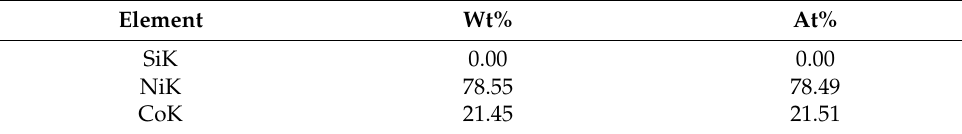
Figure 1. EDX result for the 0.5% SiO 2 /Co 2.4 Ni 0.6 O 4 material. Table 2. Elemental composition of 0.5% SiO 2 /Co 2.4 Ni 0.6 O 4 obtained in EDX.